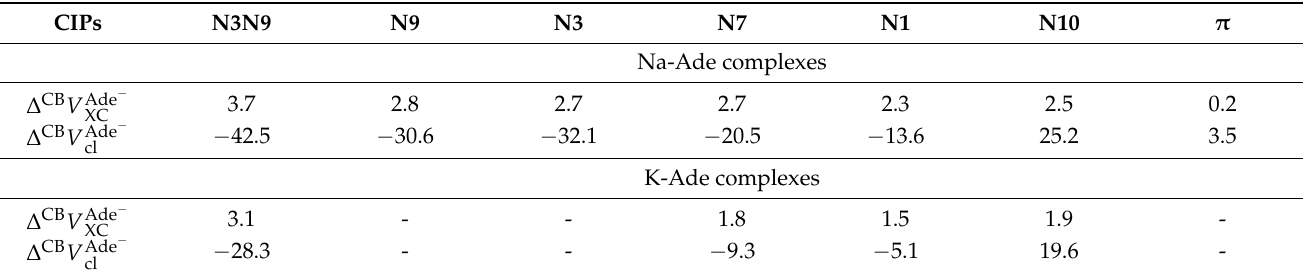
Table 3. The total change in the exchange-correlation ( ∆ CB V Ade − the interactions between covalently bonded atoms of the adeninate anion, calculated for Na-Ade and K-Ade complexes at the CCSD level. All values in kcal mol − 1